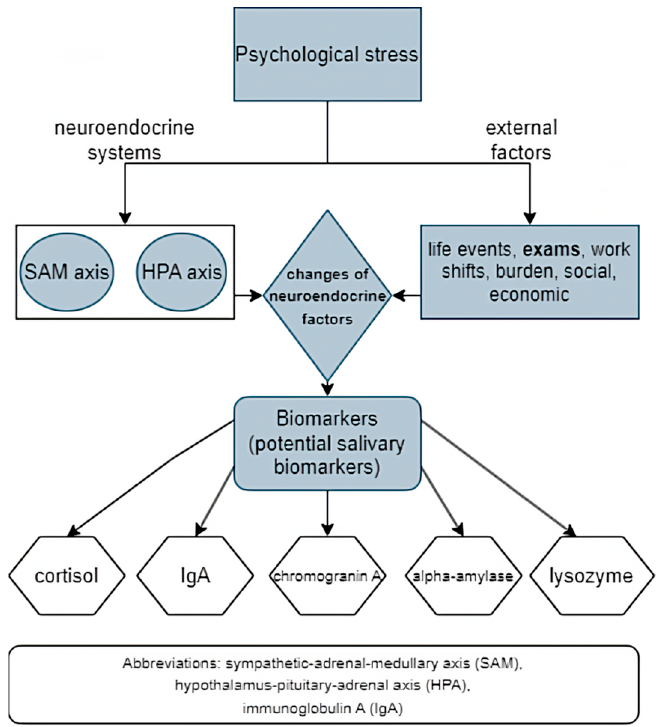
Figure 2. Psychological stress reaction, changes in neuroendocrine factors and potential salivary biomarkers (an original scheme based on current literature data).